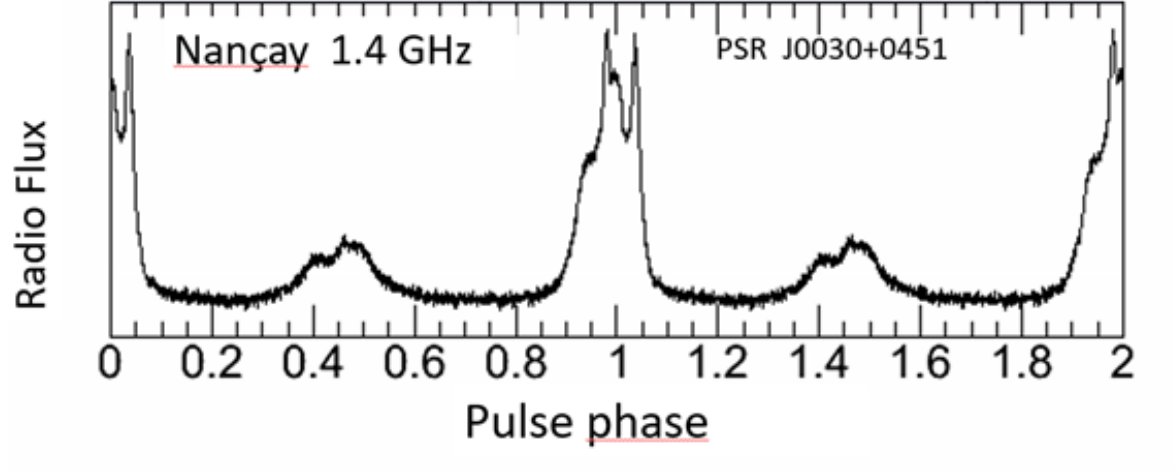
Figure 5. Light curve of the pulsar PSRJ0030+0451, a very fast pulsar (period 4.8 ms) discovered in 2000 with the Arecibo radio telescope. The main pulse is in the center; two periods are shown along the time